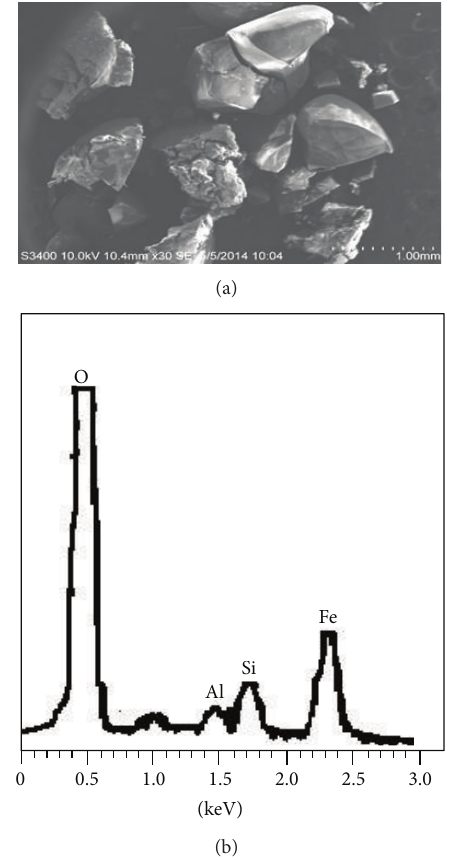
Figure 10: (a) SEM image and (b) EDX graph of FeNPs synthesized using Gardenia leaves extract. Figure 9: (a) SEM image and (b) EDX graph of FeNPs synthesized using Henna leaves extract. Table 1: Antibacterial activity of iron nanoparticles of Lawsonia inermis and Gardenia jasminoides leaves extract (30 𝜇 L/mL). Leaves extract Microorganisms Lawsonia inermis